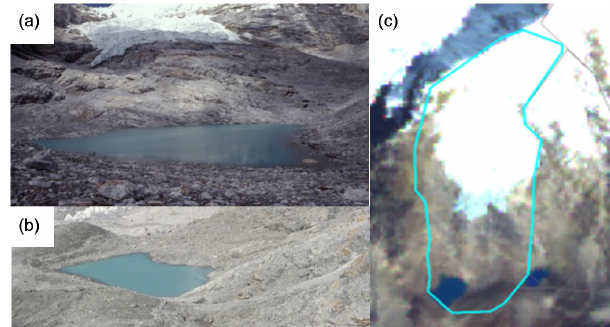
Figure 1. Example of an unconnected glacial pond (LCN5) with a glacier within the basin. Pictures were taken in September 1992 (Gabriele Tartari): (a) view looking north showing the distance be- tween the glacier and the pond surface; (b) from east showing the frontal moraine. (c) LCN5 basin tracked on ALOS 2008 imagery.